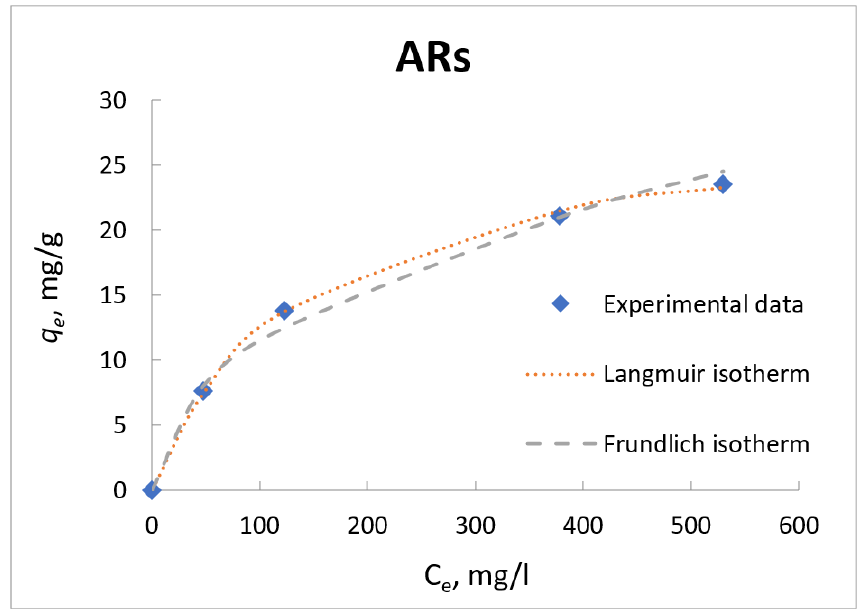
Figure 13. Adsorption isotherm for removal of oil onto AR adsorbent (1g ARs, pH 6.5, Temp.25 °C, 60 min).